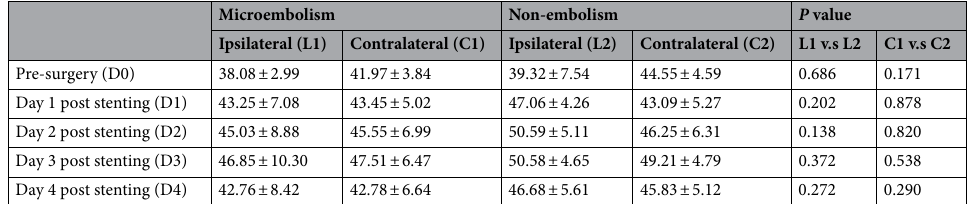
Table 5. The cerebral blood flows (mL/100 g/min) in temporal lobe of patients with or without